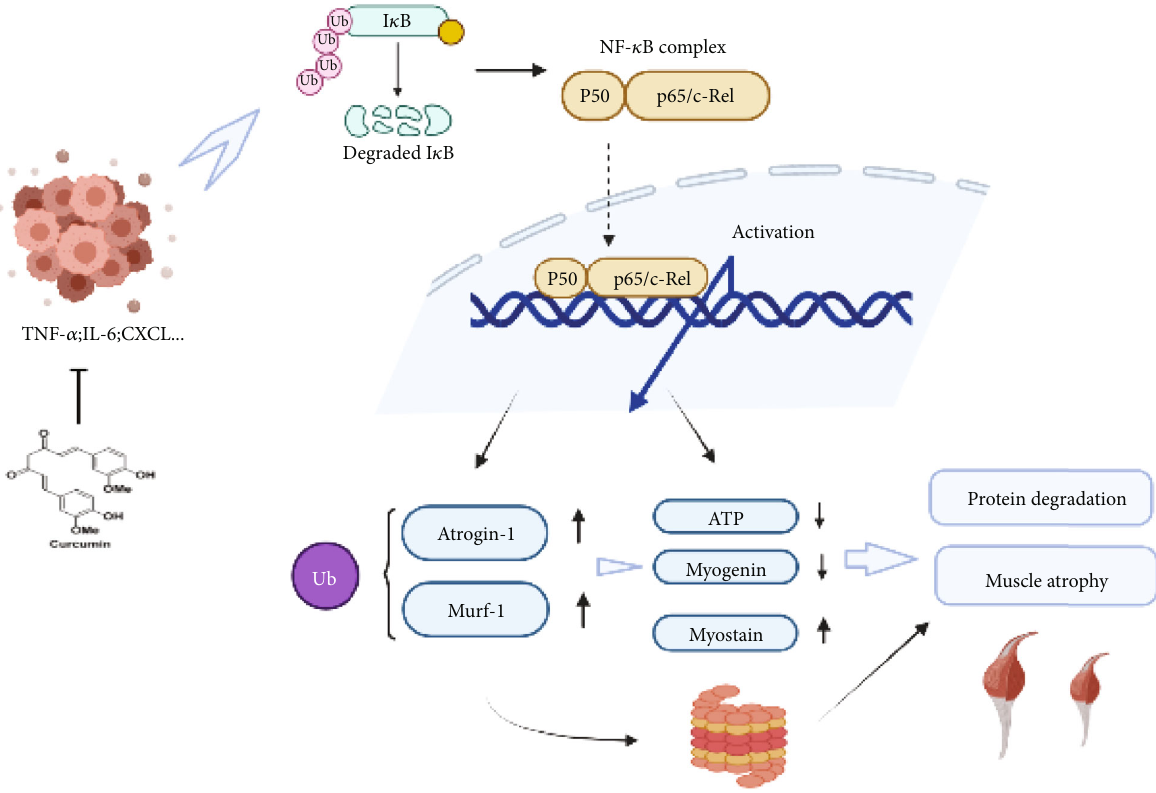
Figure 9: Therapeutic mechanism of curcumin on muscle atrophy in triple-negative breast cancer